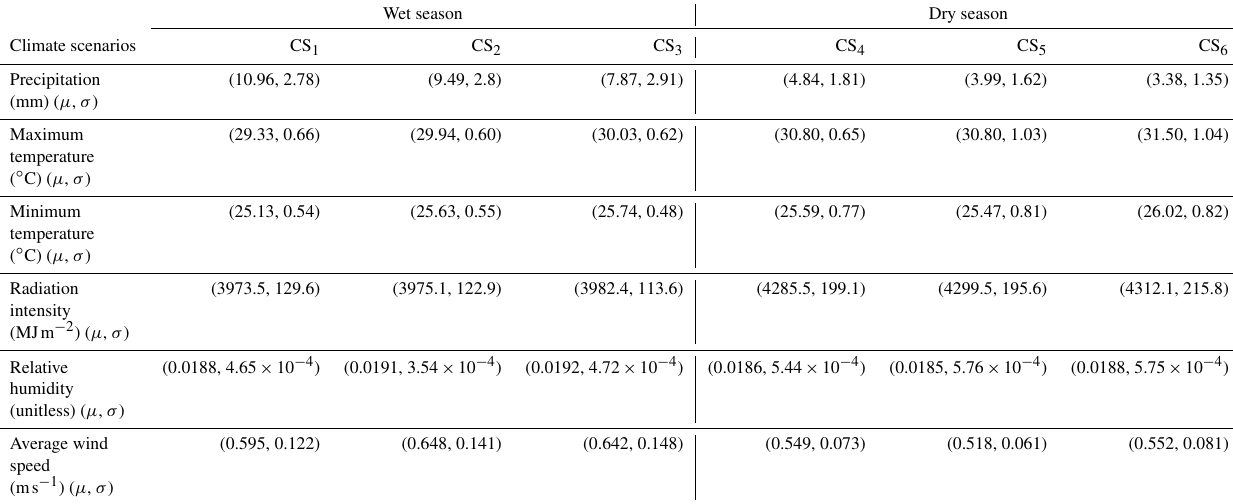
Figure 3. We identified six CSs based on precipitation data for 1998–2013 from NASA’s TRMM data (https://trmm.gsfc.nasa.gov/ publications_dir/TRMM_Reentry_Risk_Assessment_FINAL_20150604.pdf). The first climate scenario (CS 1 ) is the wettest one, and the sixth climate scenario (CS 6 ) is the driest one. Table 1. Statistical information for the daily data for the six CSs. Here, µ represents the mean value and σ represents the SD. Wet